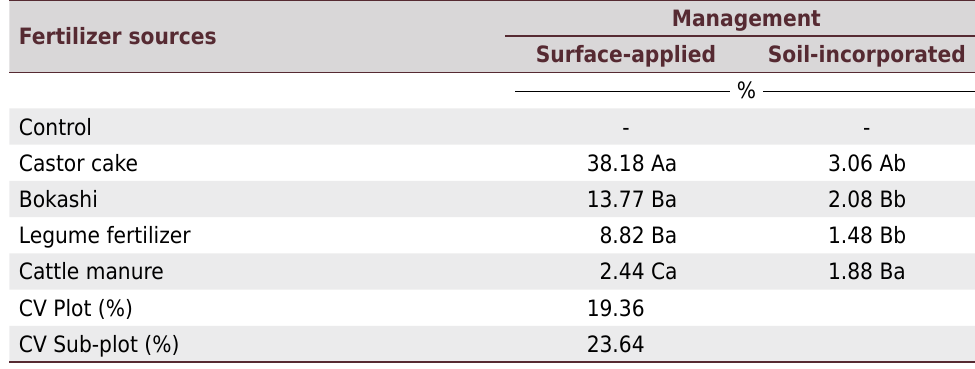
Table 5. Ammonia volatilization rate from different fertilizers applied to summer/autumn corn